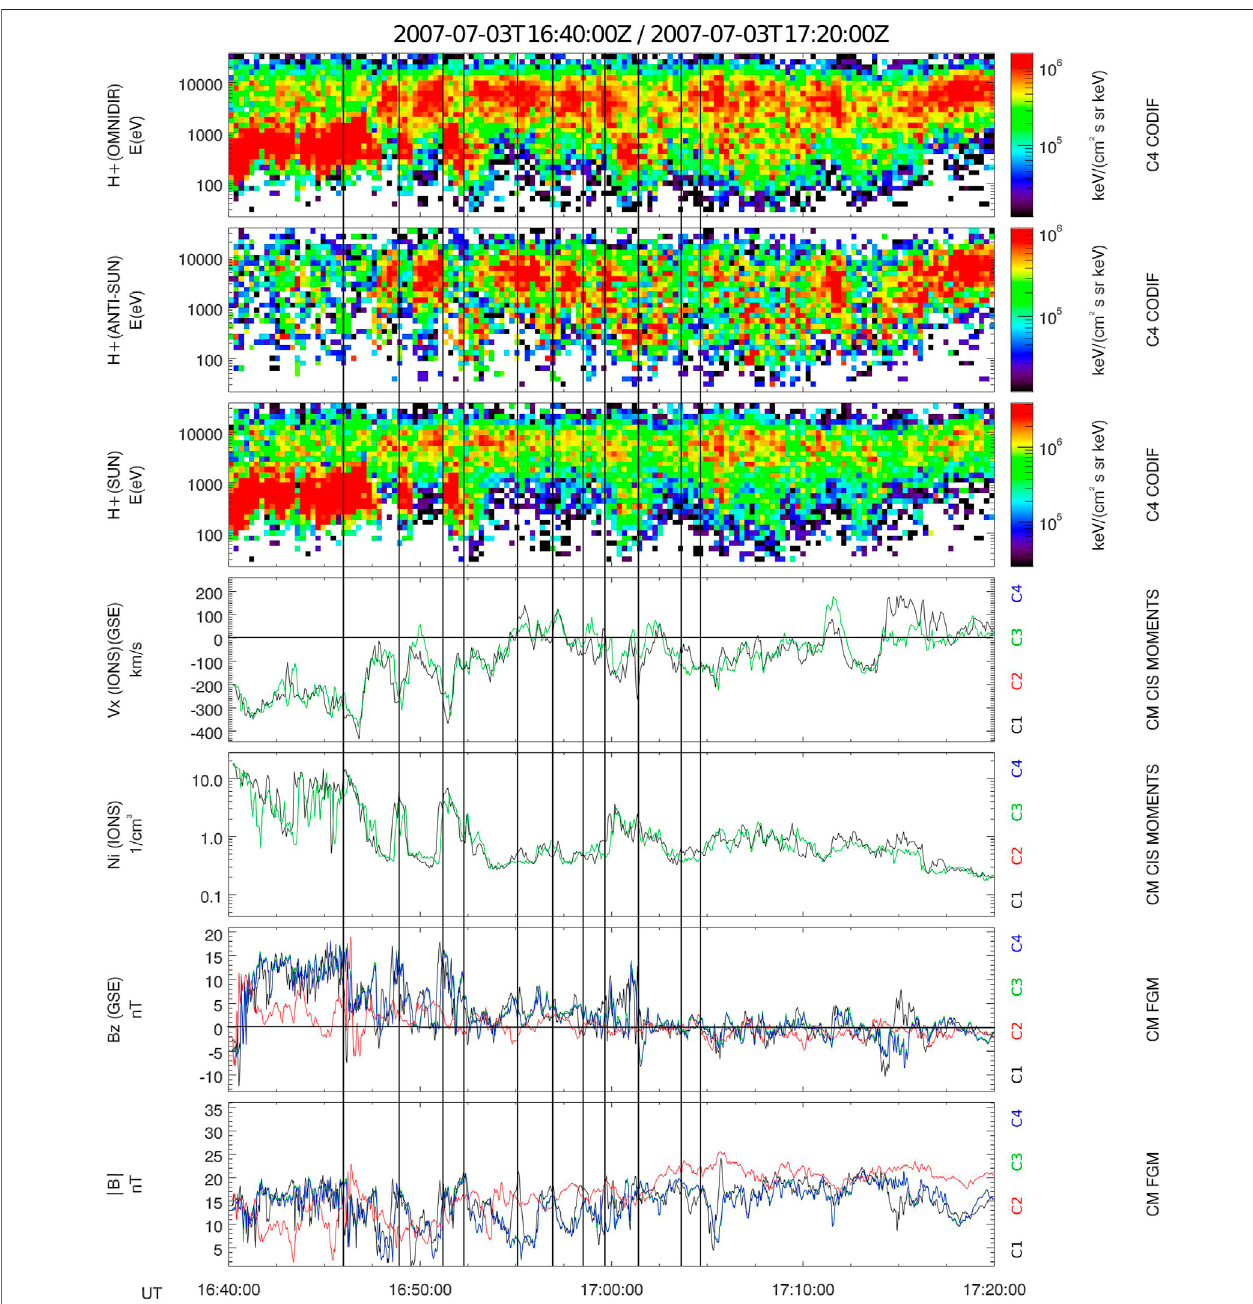
FIGURE 1 | Cluster CIS observations from July 3, 2007, 1640 – 1,720 UT. From top to bottom: CODIF energy-time spectrograms of proton energy fl ux: omnidirectional, measured by the anti-sunward sensors and by the sunward sensors, in keV cm − 2 s − 1 sr − 1 keV − 1 , from SC 4; ion density, cm − 3 , from SC 1 & 3; X-componentionvelocity,km s − 1 (GSE),fromSC1&3;Z-componentandthemagnitudeofthemagnetic fi eld,nT(GSE),fromSC1 – 4.Theblackverticalsolidlinesshow the times of strong maxima in the total pressure pro fi le de fi ned in Figure 3